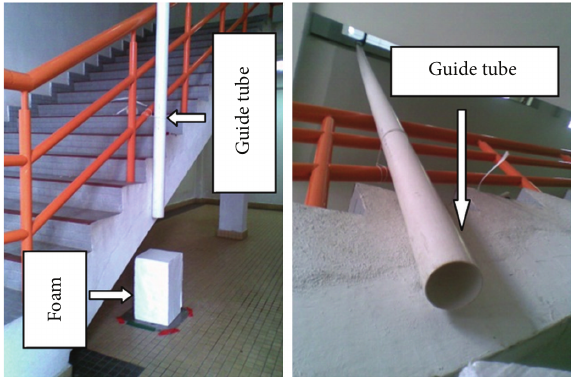
Figure 4: Set-up for drop test experiment.